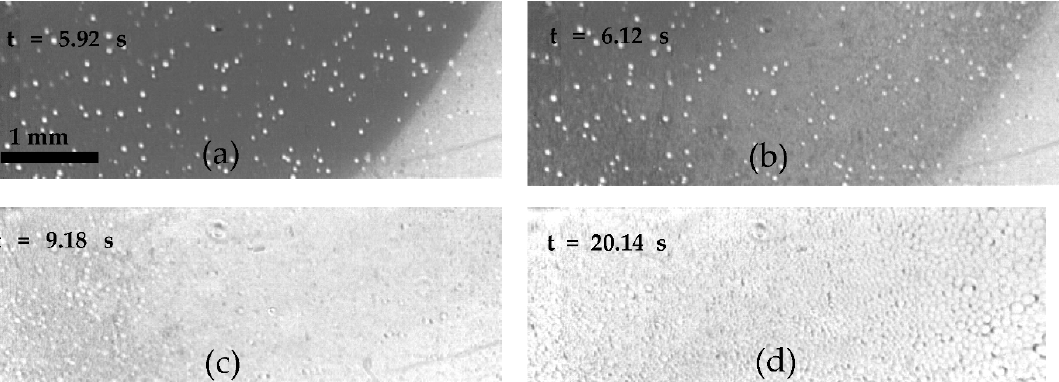
Figure 5. Selected time-lapse images at ( a ) 5.92 s, ( b ) 6.12 s, ( c ) 9.18 s, and ( d ) 20.14 s during the first stage, Onset (stage I) of USDC provide inconclusive evidence on whether a thin film larger than a monolayer exists on the surface; the images are recorded using SPRi at 680 nm.